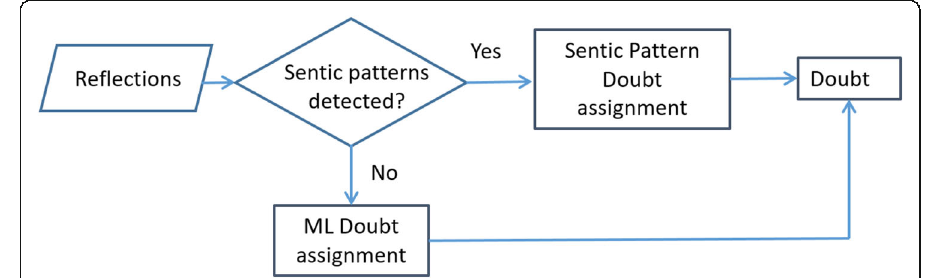
Fig. 3 Hybrid doubt identification approach using sentic patterns and ML